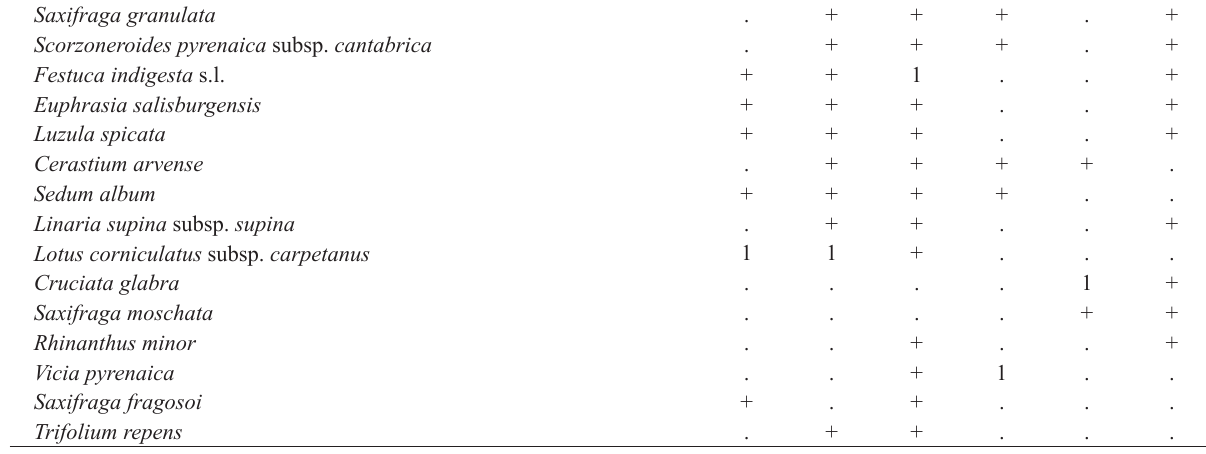
Table 2. Alchemillo alpinae-Salicetum breviserratae ass. nova ( Salicion herbaceae, Salicetalia herbaceae, Salicetea herbaceae ) Saxifraga granulata